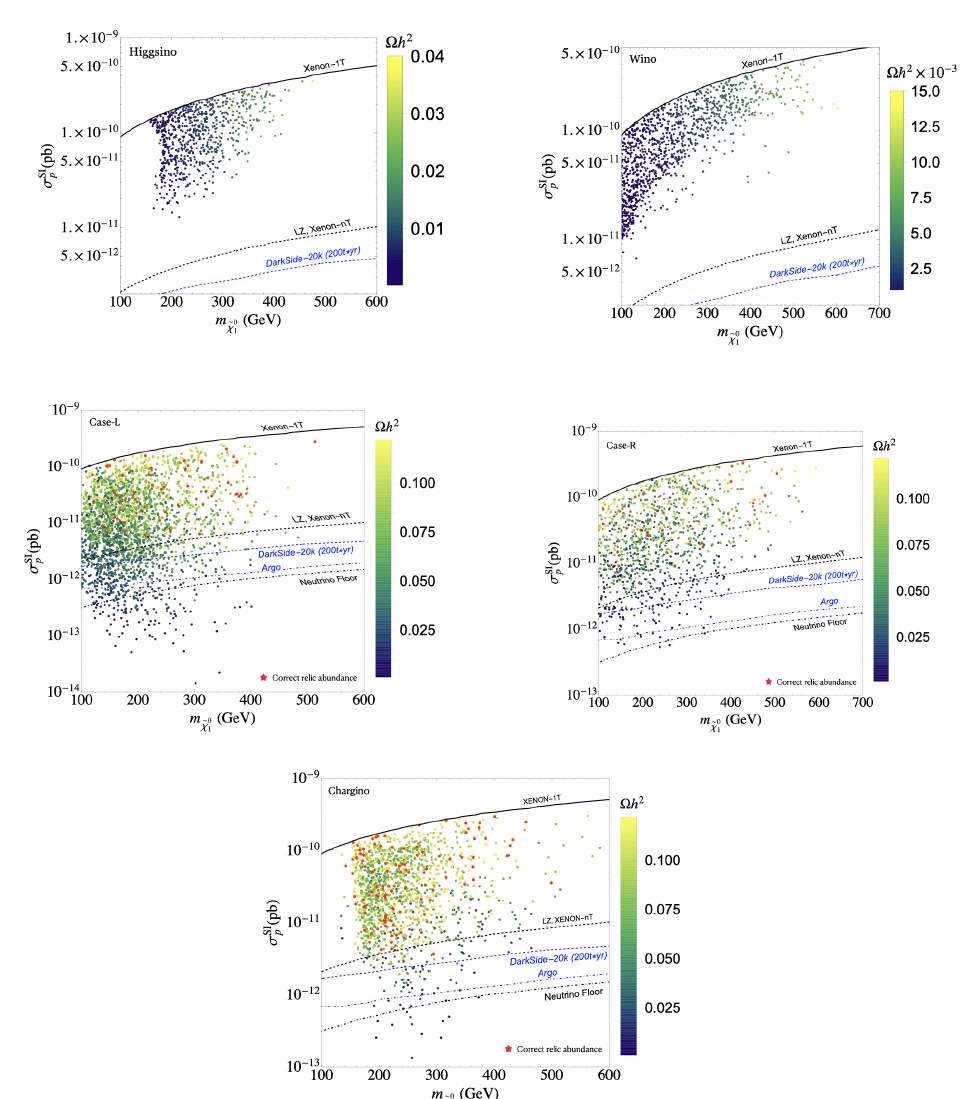
Figure 3. The results of our parameter scan in the five DM scenarios in the m code indicates the DM relic density. Red points are in full agreement with the Planck